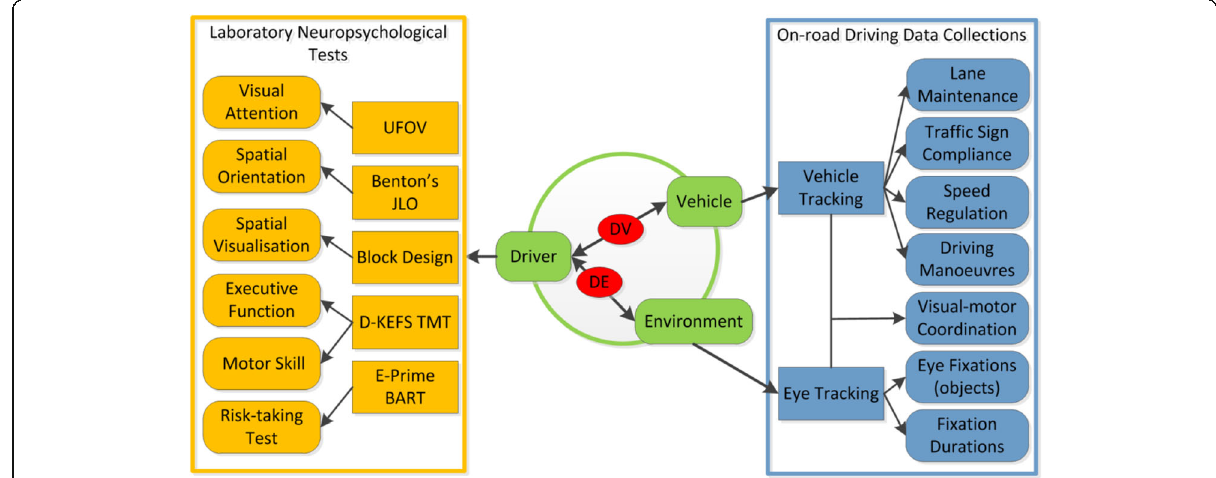
Fig. 2 Data collection protocol - laboratory and on-road